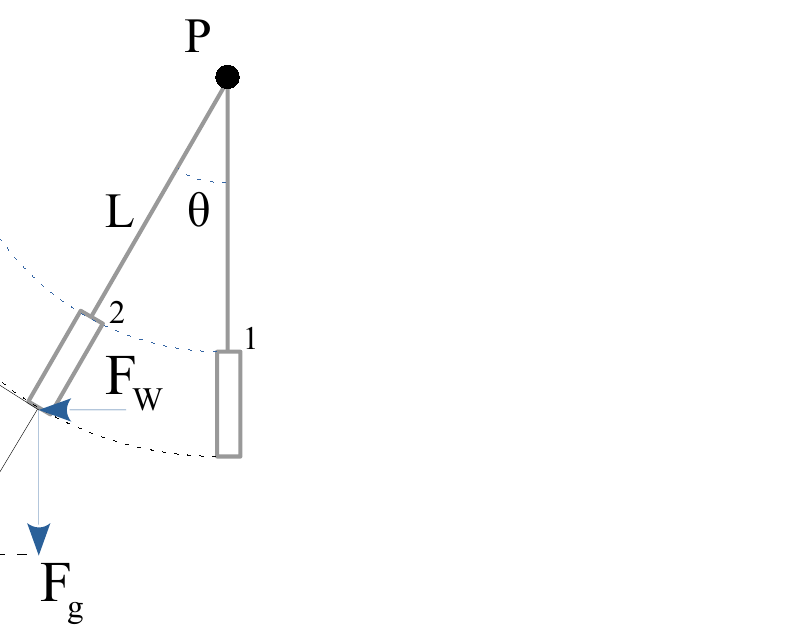
Figure 1. The measurement device and its basic